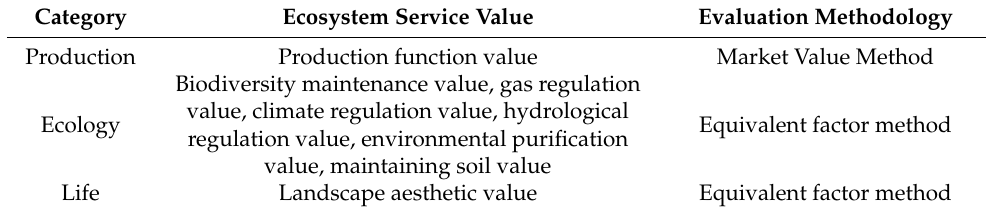
Table 3. Classification of ecosystem functions in the project